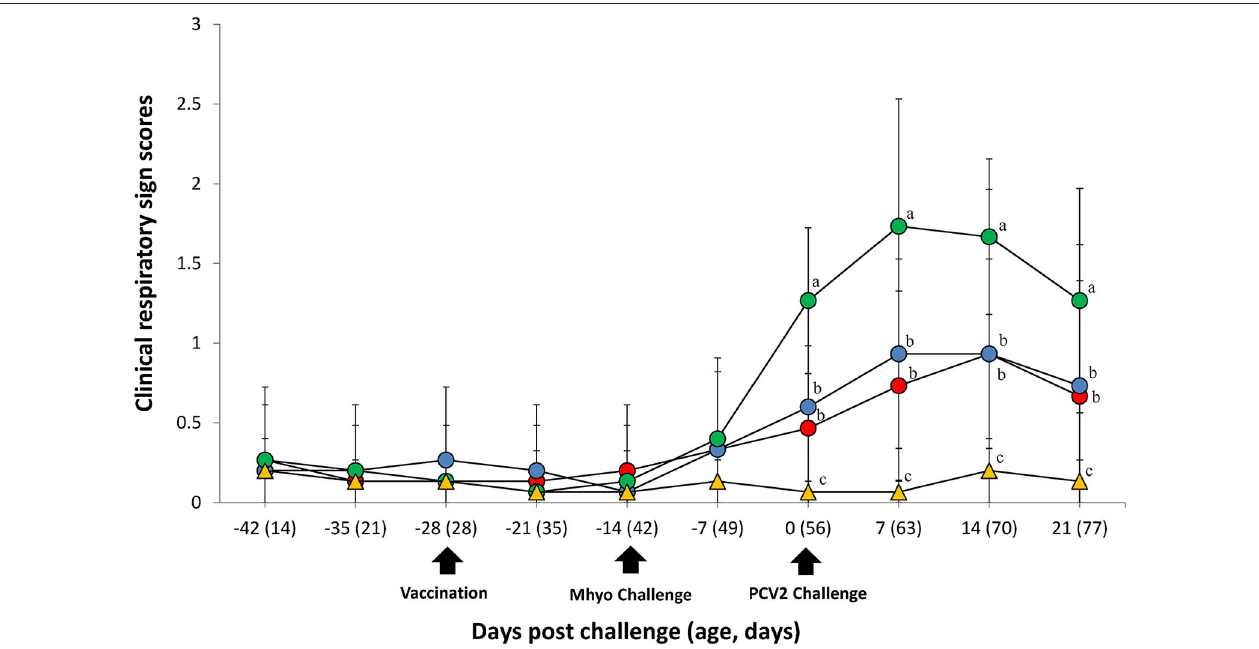
FIGURE 1 | Clinical resipiratory sign. Clinical respiratory sign scores in the different groups: VacA/Ch (•), VacB/Ch (•), UnVac/Ch (•), and UnVac/UnCh ( N ). Different letters within a sampling point mean statistically significant differences ( P < 0.05). Variation is expressed as the standard deviation.